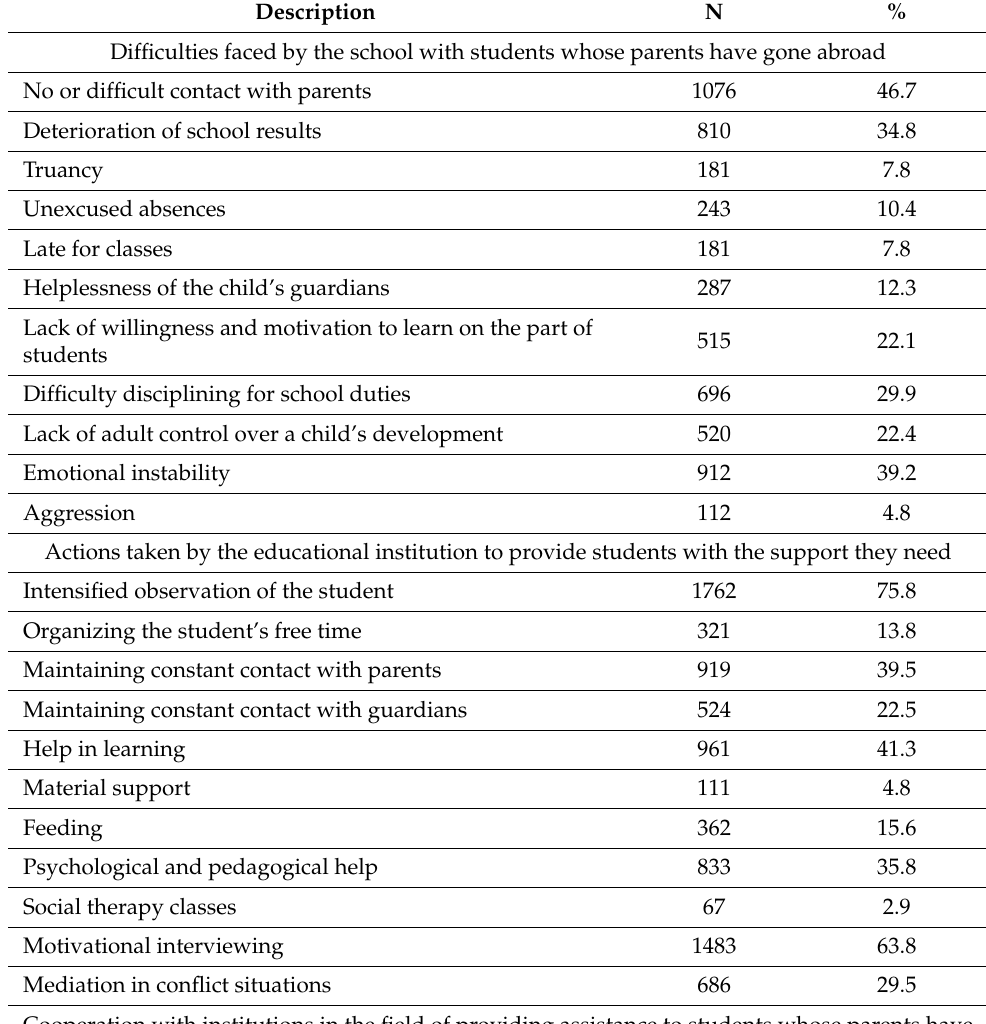
Table 2. Problems and actions taken to provide the students with the necessary